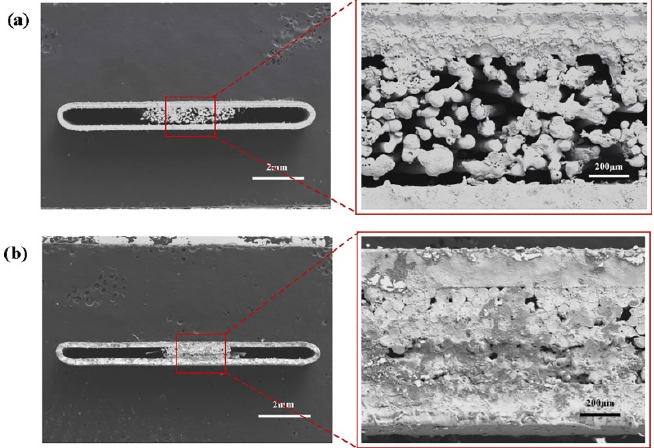
Figure 7. SEM image of a spiral braided mesh wick ultra-thin heat pipe [40]. ( a ) t = 1.0 mm ( b ) t = 0.8 mm.